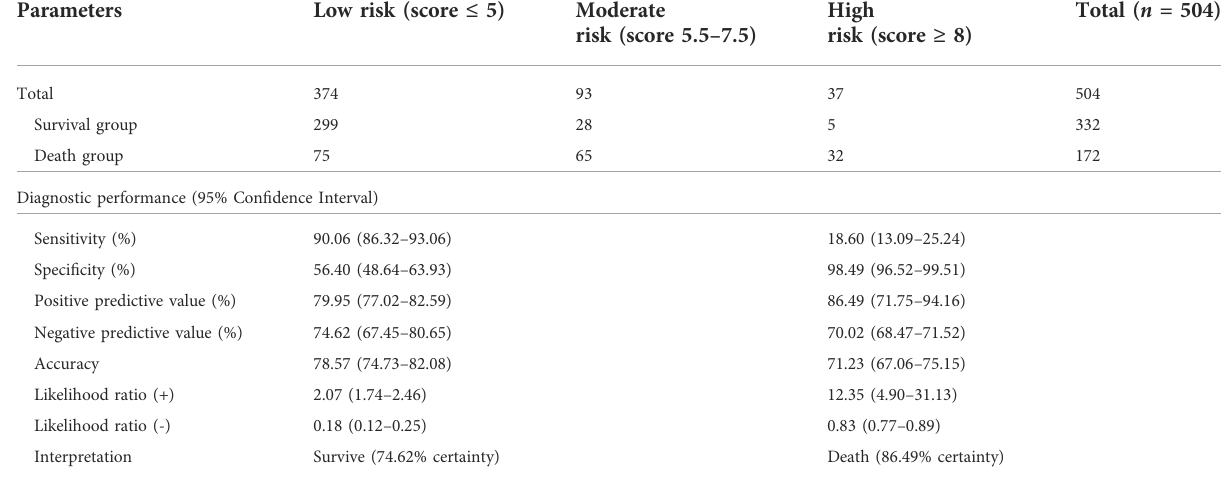
TABLE 4 Distribution of the risk of mortality in patients with MDROs and diagnostic performance.